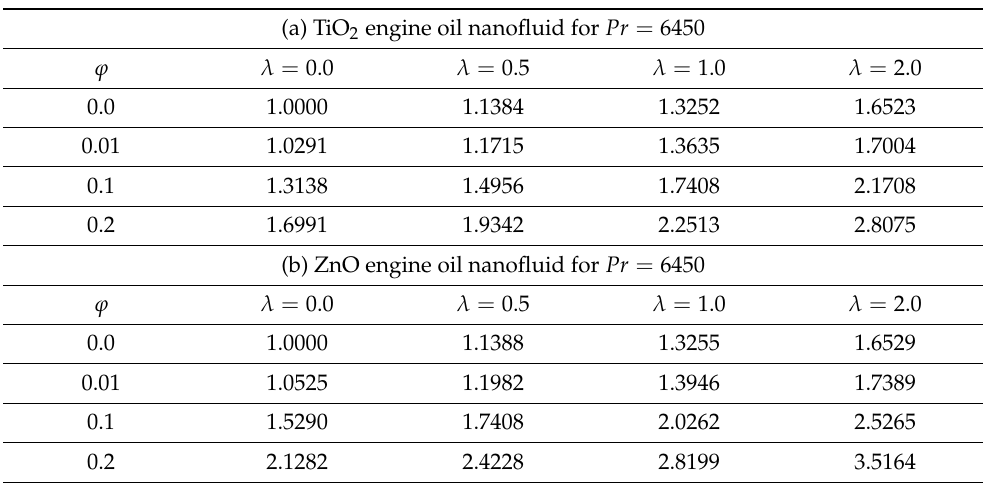
Table 2. Variation of distinct parameters on Cf x ( skin friction along x -axis) (a,b), Cf y (skin friction along y -axis) (c, d) and Nusselt number Nu x (e,